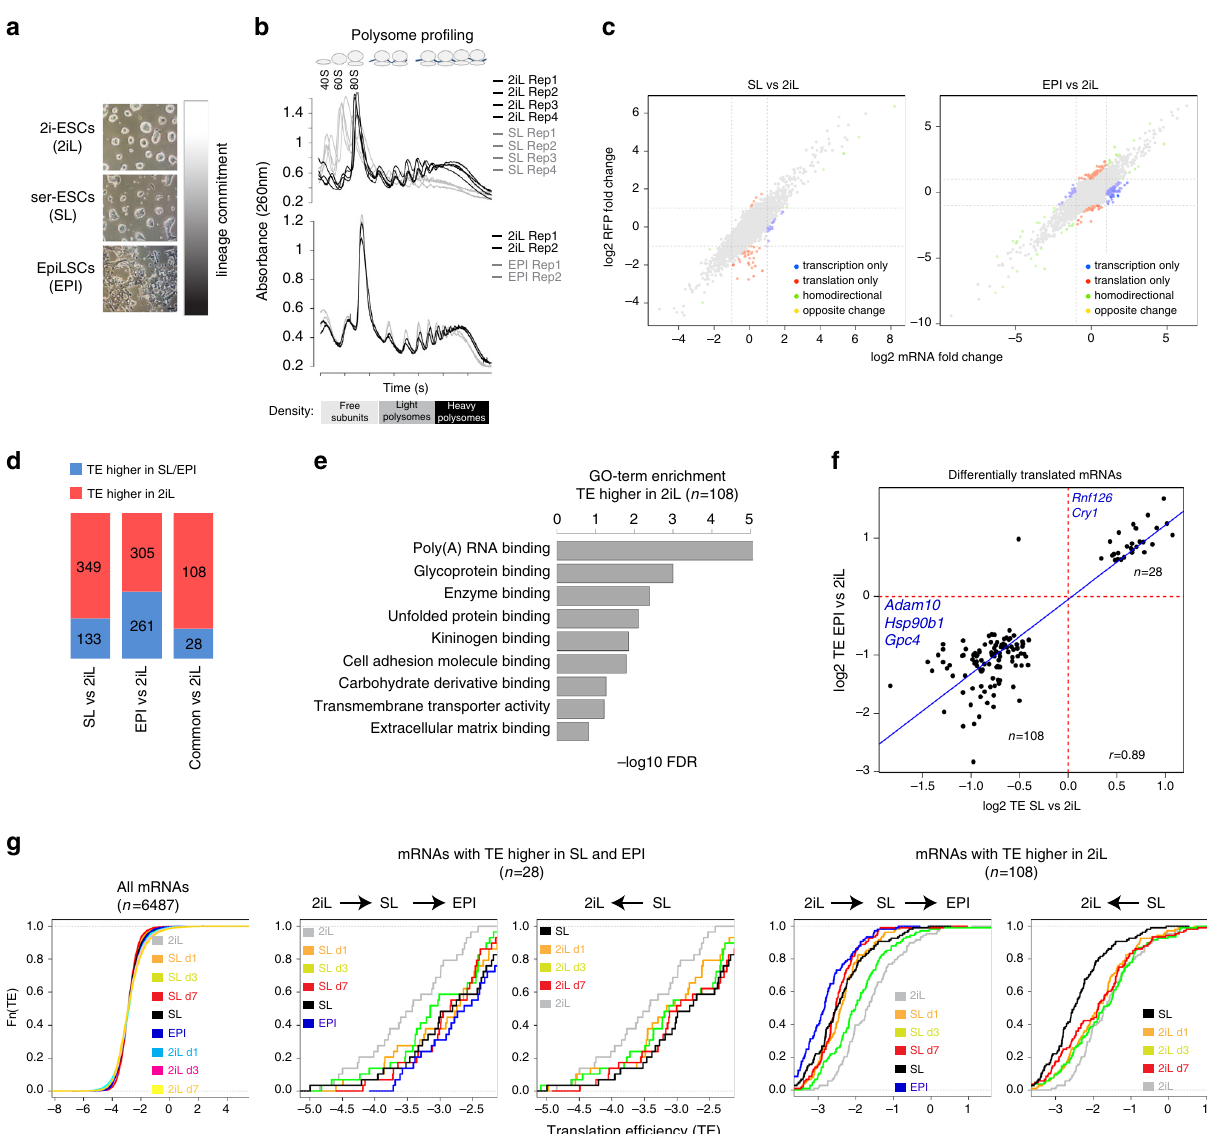
Fig. 1 The translational landscape of different states of pluripotency. a Schematic representation of the different ES states employed in this study. Scale bar, 100 µ m. b Polysome fractionation performed in 2iL, SL, and EPI. n = 4 biological replicates for 2iL vs. SL and n = 2 biological replicates for 2iL vs. EPI comparison. c Scatter plots showing the association between mRNA and RFP fold-change in SL or EPI when compared to 2iL state. Differentially translated mRNAs (FDR < 0.1 and fold-change >1.5 using Xtail analysis pipeline) are highlighted in different colors based on the direction of mRNA and RFP changes. Homodirectional = mRNA and RFP display change in the same direction (up or downregulated). Opposite change = mRNA and RFP display change in opposite directions. P values were adjusted for multiple testing using Benjamin – Hochberg correction, n = 6487 mRNAs. d Bar plots showing the number of differentially translated mRNAs in SL, EPI, or in both ( “ common ” genes) when compared to 2iL state. Differentially translated mRNAs are de fi ned by FDR < 0.1 and fold-change >1.5 using Xtail analysis pipeline. P values were adjusted for multiple testing using Benjamin – Hochberg correction, N numbers represent mRNAs and are stated in the fi gure. e GO-term enrichment analysis for the “ common ” genes with higher TE in 2iL cells. Two-sided values were adjusted for multiple testing using Benjamin – Hochberg correction, n = 108 mRNAs. f Scatter plot showing the correlation of TEs in SL and EPI states. The set of “ common ” genes were used in this analysis and representative examples were highlighted in the fi gure. R -values represent Pearson correlation coef fi cients, N numbers represent mRNAs and are stated in the fi gure. g Plots showing the change of TE at different time points of SL-to-2iL or 2iL-to-SL transition. The set of “ common ” genes were used in this analysis. “ All ” genes were also included for comparison. N numbers represent mRNAs and are stated in the fi